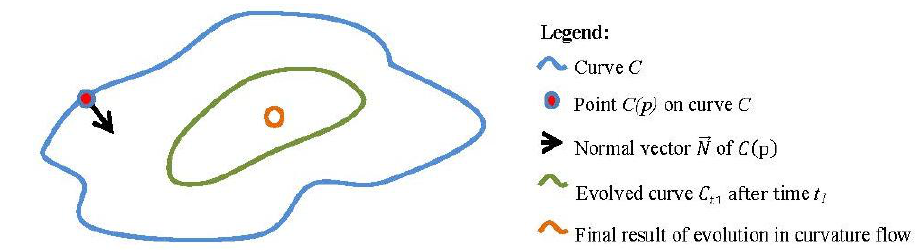
Figure 5. Curve evolution in curvature